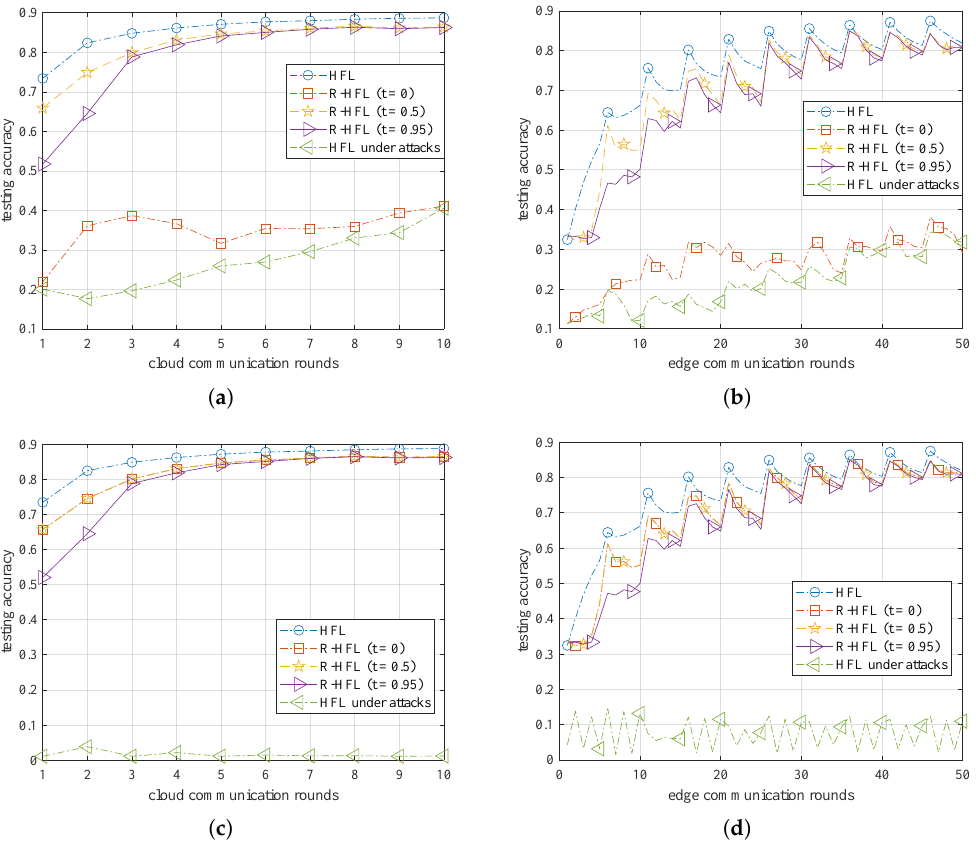
Figure 3. Effect of Threshold t for defending against (i) ANMP and (ii) SFMP attacks. ( a ) ANMP: global model performance varying with t , ( b ) ANMP: edge model performance varying with t , ( c ) SFMP: global model performance varying with t , ( d ) SFMP: edge model performance varying with t